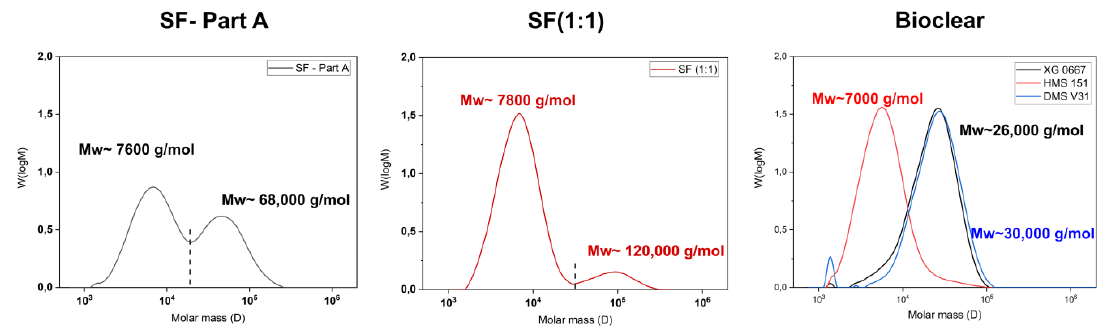
Figure A1. Gel-permeation chromatography (GPC) elution spectrums of normalized distributions vs. molar mass of components of SF (Part A), crosslinked SF (1:1), and the components of Bioclear (XG 0677, HMS151, DMS V31). The dashed line in both SF-Part A and SF (1:1) represents the integration limit.